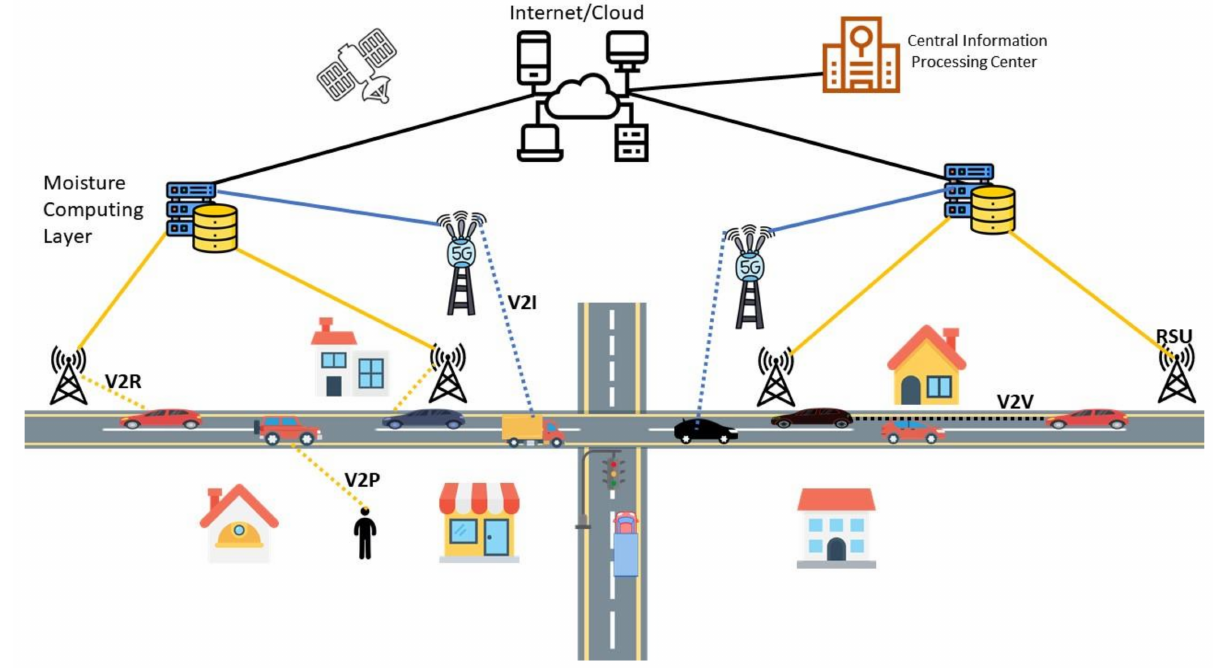
Figure 2. The proposed moisture computing Internet of vehicle (IoV) communication